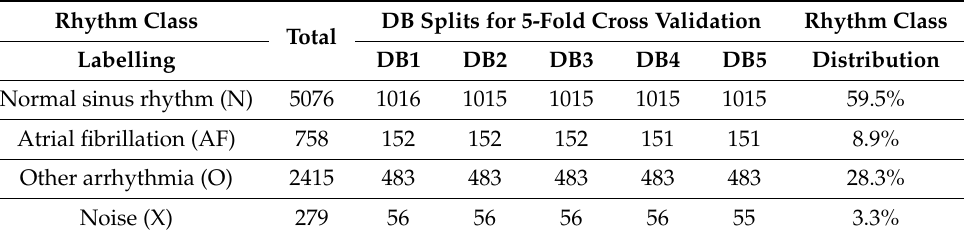
Table 1. Number of recordings in total database and 5 splits for cross-validation. The rhythm distribution within DB spits is preserved equal to the one in total